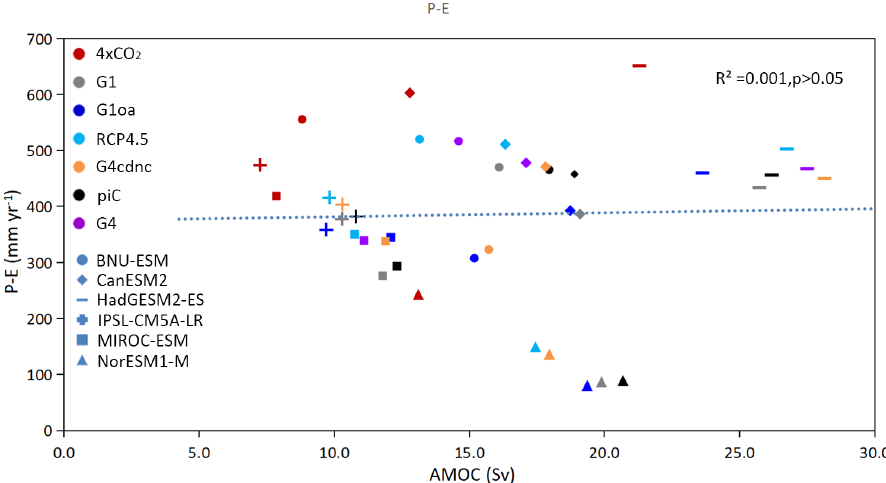
Figure 9. Model mean of P − E (mmyr − 1 ) over the 40-year analysis period in the three deep convective regions (outlined in Fig. 6). The dotted line is the linear regression trend line of AMOC intensity and upward heat flux (area average of the deep convective regions) over the 40-year analysis period in all six